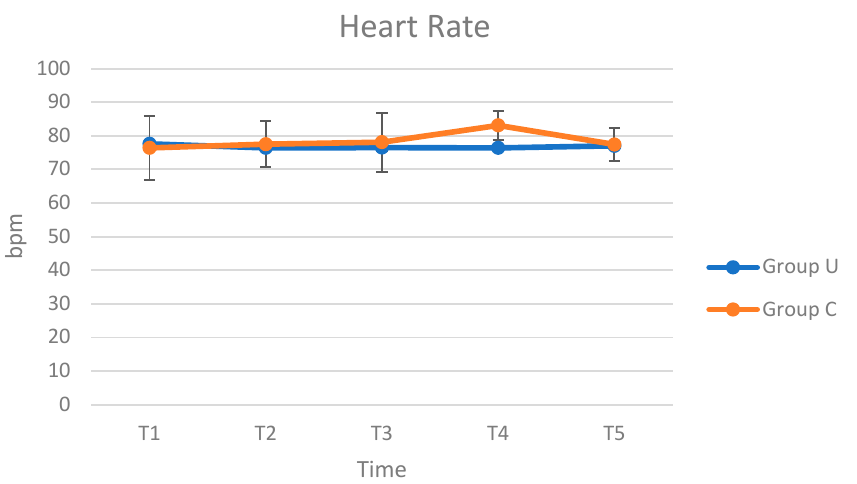
Figure 3. Average HR (bpm) values in Group U (pigs underwent ultrasound examination before cryptorchidectomy) and Group C (control group, without ultrasonography), at times T1 (surgical preparation, after placing the animal on the operating table and inducing anaesthesia), T2 (skin incision), T3 (manipulation of the testicle), T4 (resection of the testis and release of residual stump of the spermatic cord), and T5 (end of surgery, after applying the last simple stitch on the skin).